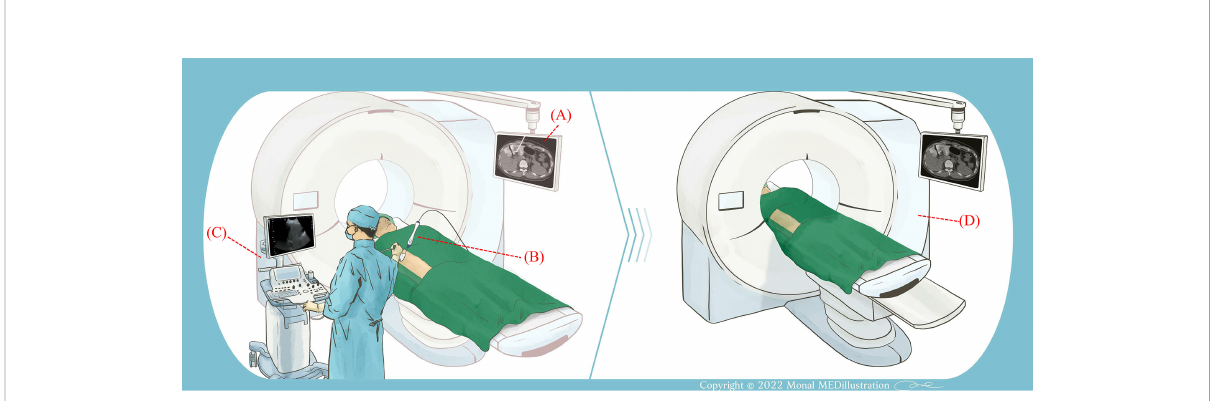
FIGURE 1 Illustration of the experimental procedure. (A) CT was used to measure the size of the liver tumor and guide the placement of the RF needle electrode. (B) After determining the electrode position, the RFA system was activated and ablation was performed. (C) An ultrasound system